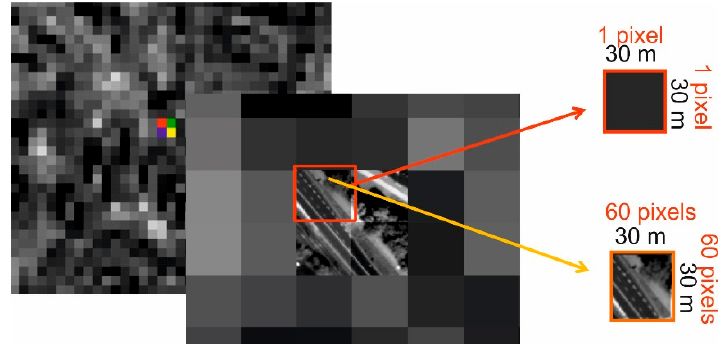
Figure 5. The relation between the pixel size of a panchromatic and multispectral image. One pixel of the multispectral image from the Landsat satellite (GSD = 30 m) corresponds to 60 × 60 pixels of the panchromatic image from the WorldView-2 satellite (GSD = 0.5 m).